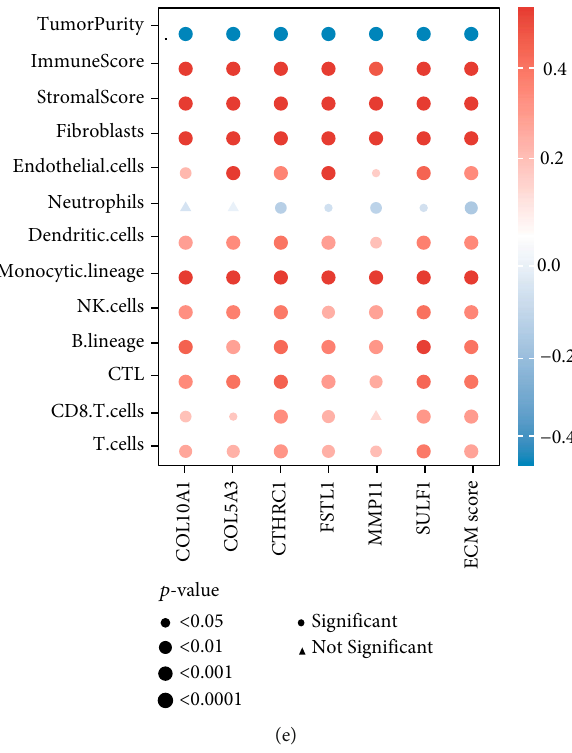
Figure 5: ECM score and hub genes are signi fi cantly positively correlated with stromal and immune cell abundance in multiple datasets including (a) GSE32894, (b) GSE13507, (c) GSE31684, (d) GSE32548, and (e) TCGA-BLCA